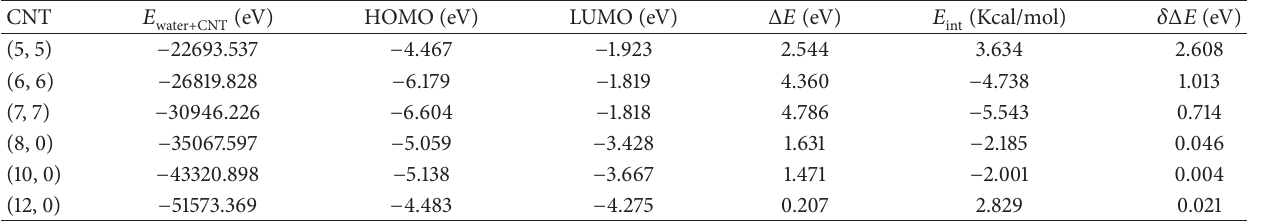
, 𝐸 , band gap, the interaction energy ( 𝐸 int ), and the change in band gap. HOMO LUMO